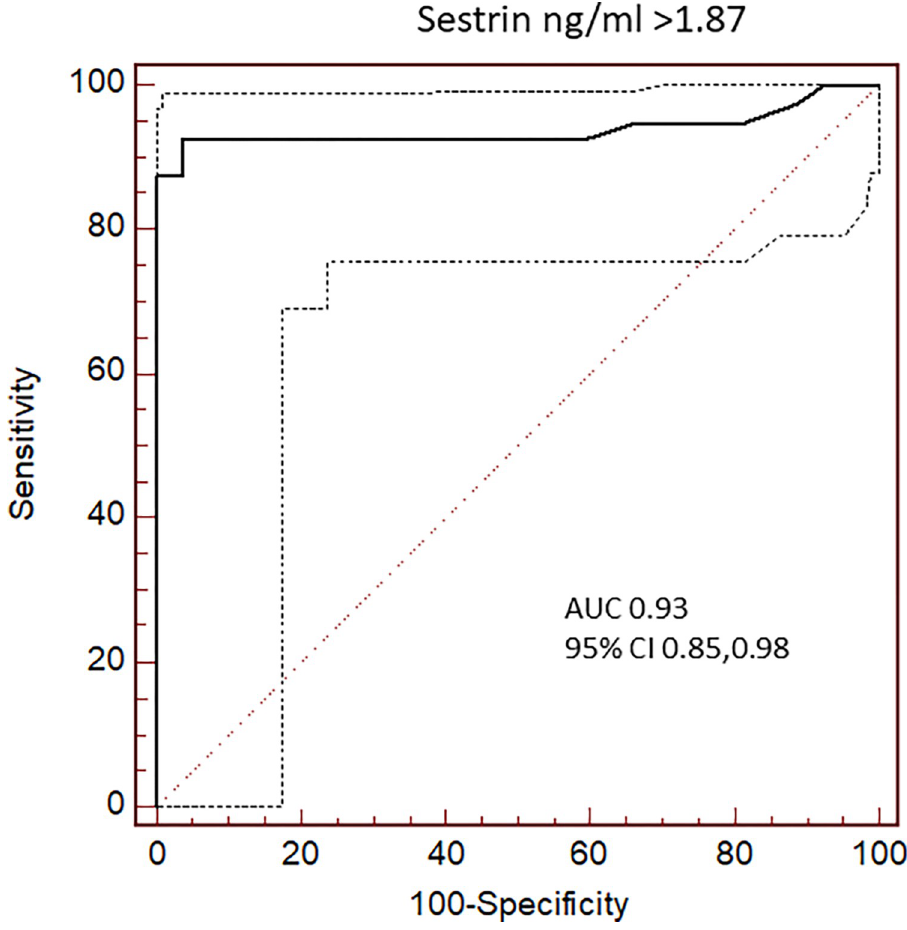
Fig 4. Diagnostic performance of Sesn2 for the presence of significant emphysema in High Resolution Computed Tomography (HRCT). For data see text.